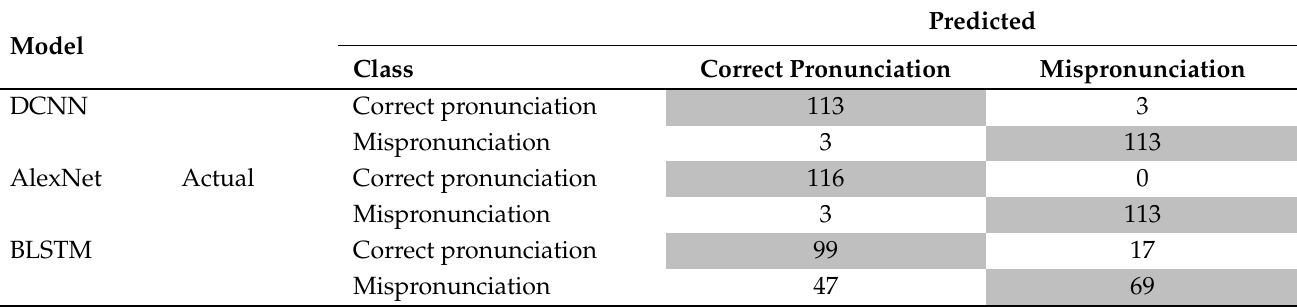
Table 10. DCNN without data augmentation.